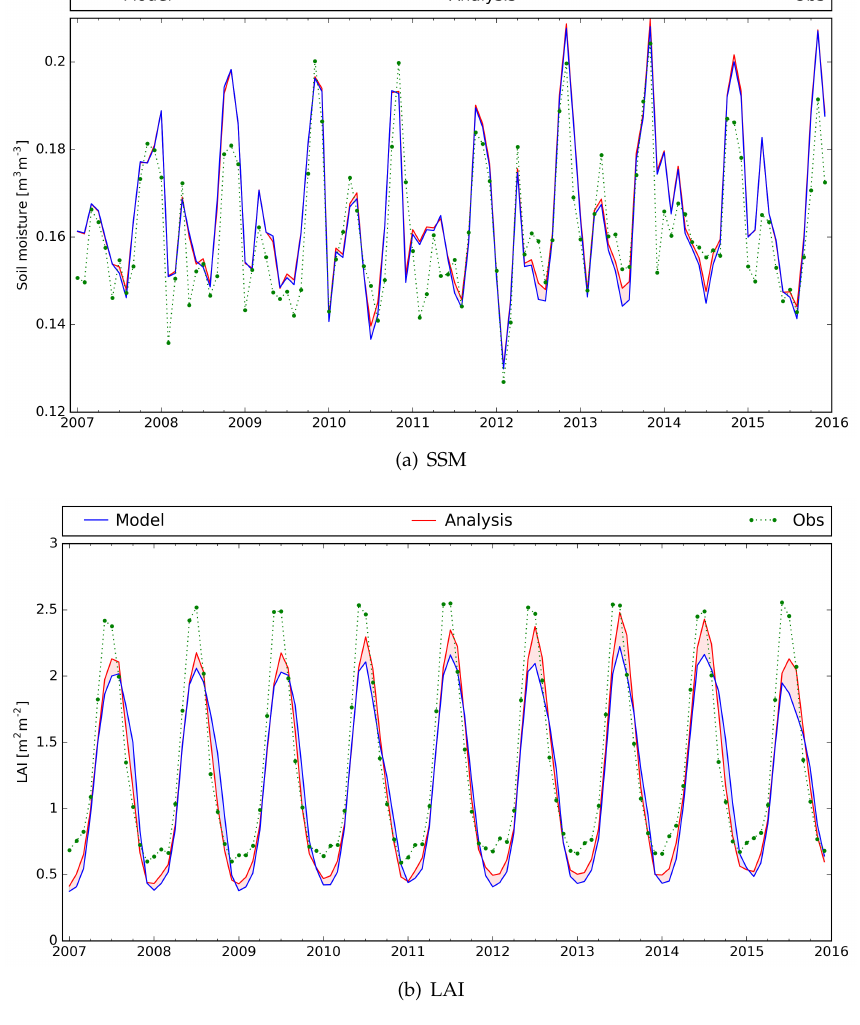
Figure 2. Monthly time series of the observations (green), open-loop (blue) and analysis (red) simulations from 2007–2015 averaged over the Euro-Mediterranean area for: ( a ) Surface Soil Moisture (SSM) and ( b ) Leaf Area Index